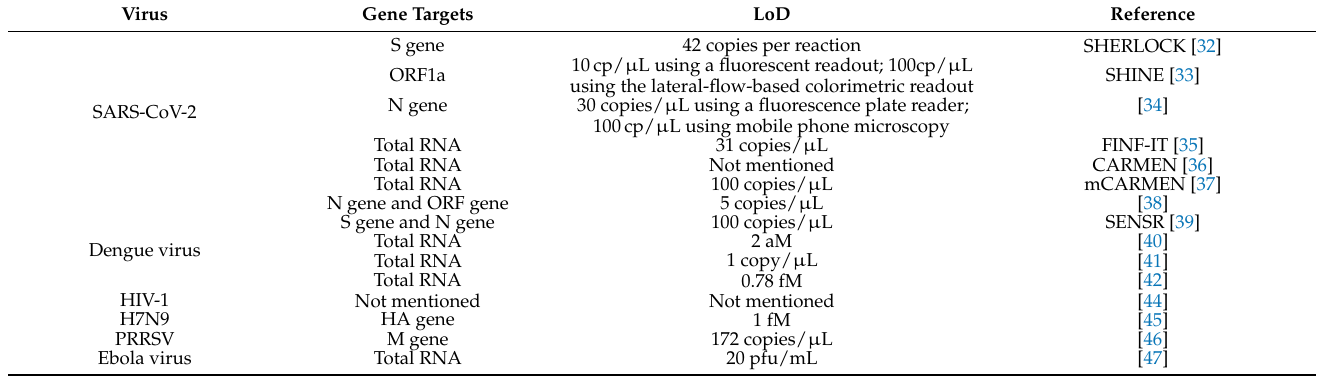
Table 1. CRISPR-Cas13-based RNA virus